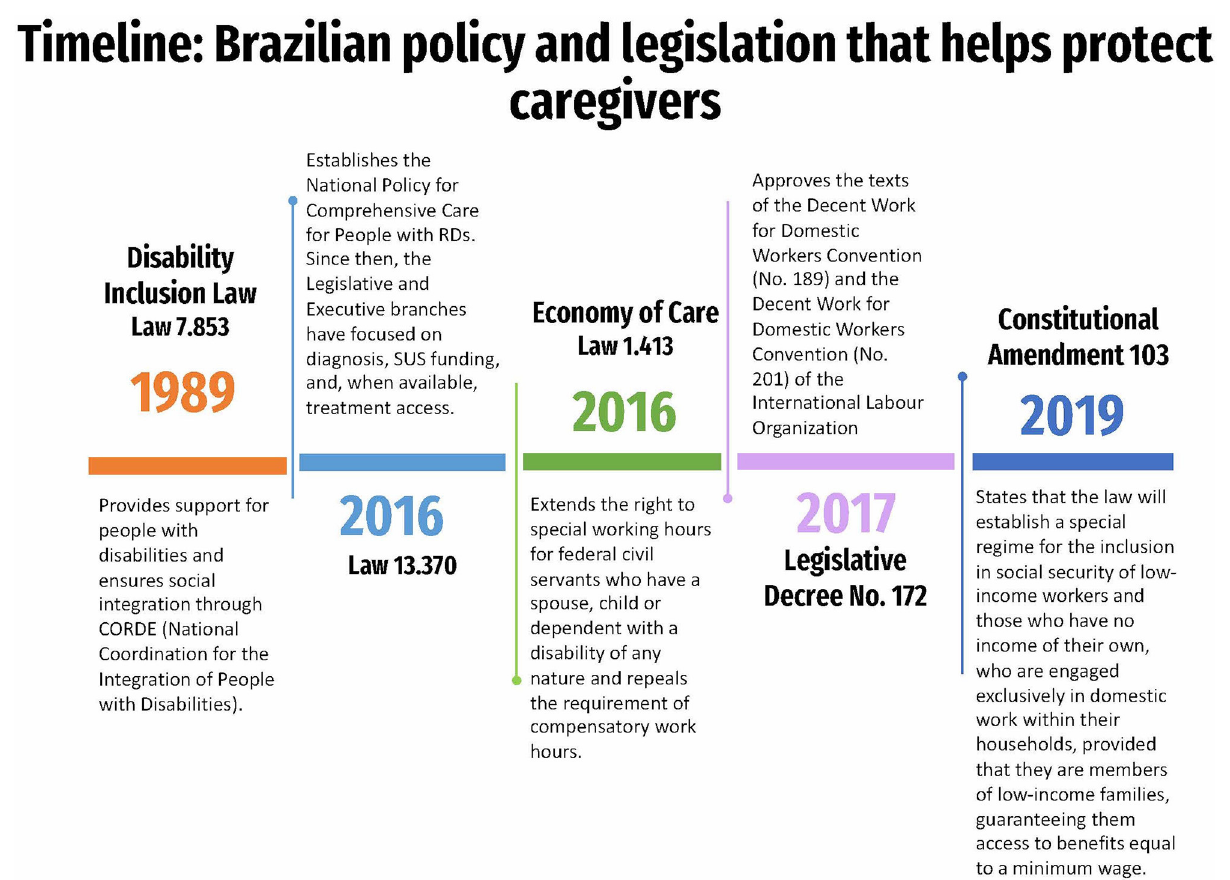
FIGURE2 A timeline of the legislation passed in Brazil that helps protect caregivers. RDs, Rare disease; SUS, Sistema Único de Saúde (Brazilian public healthcare system).